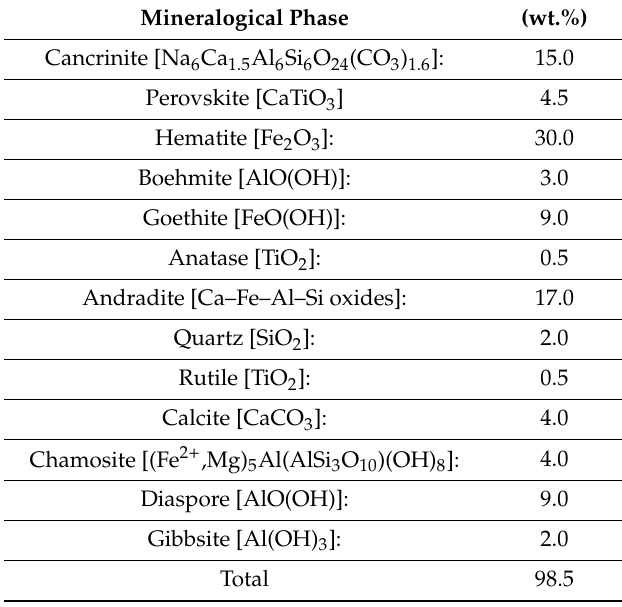
Figure 2. Red mud samples, ( left ) from Germany, ( right ) from Greece. The XRD analysis of Greek Red Mud is presented in Table 3. Table 3. X-ray di ff raction analysis (XRD) analysis of Greek red mud ( d = 1.87 µ m).